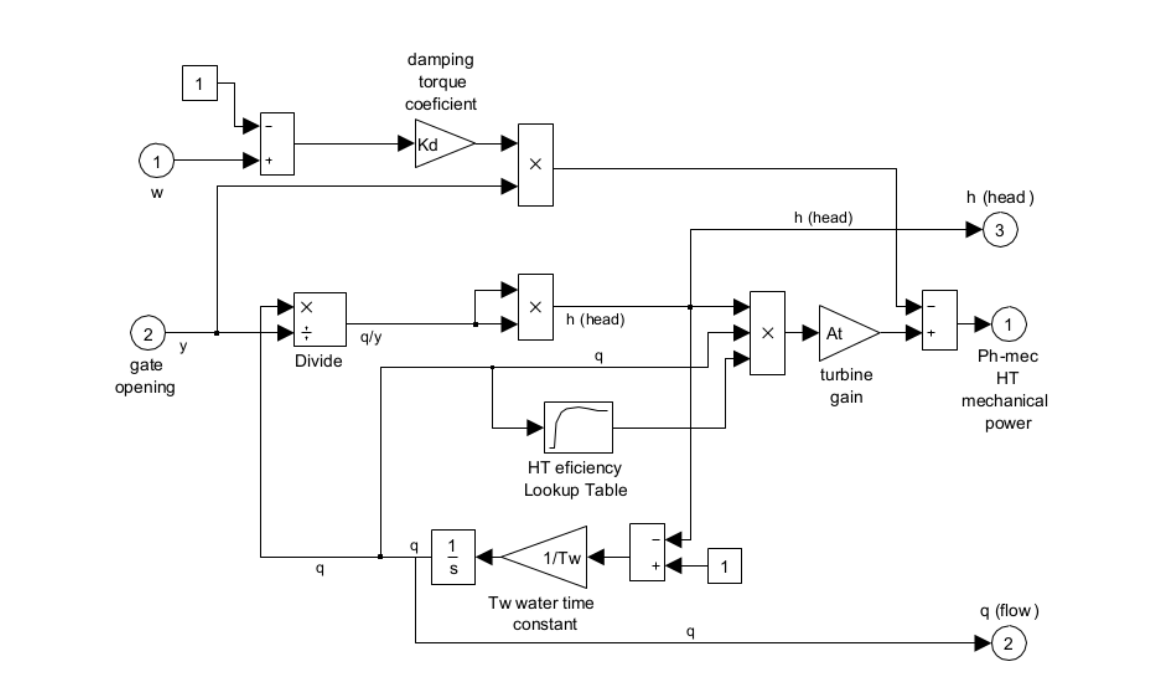
Figure 4. Hydraulic turbine Simulink